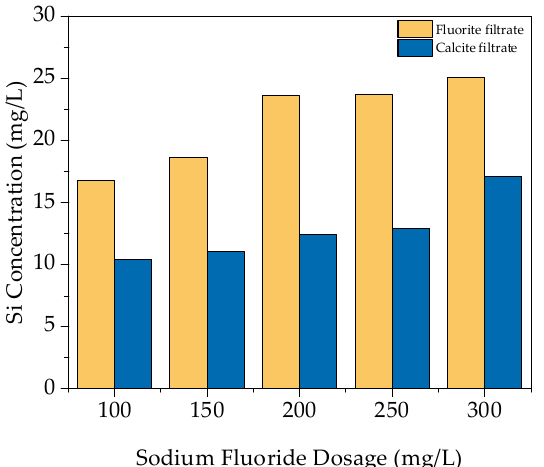
Figure 7. Effect of NaF dosage on silicon concentration in fluorite and calcite filtrate.